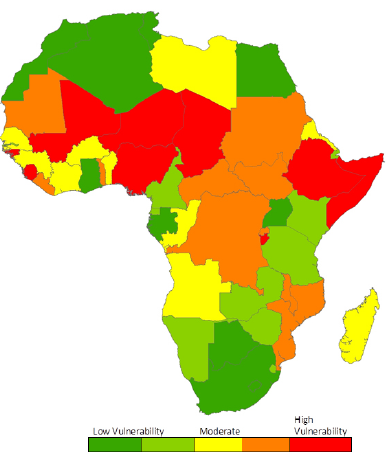
Fig. 8. Drought vulnerability index (DVI). The different levels of vulnerability were classified by dividing the sample in quintiles.